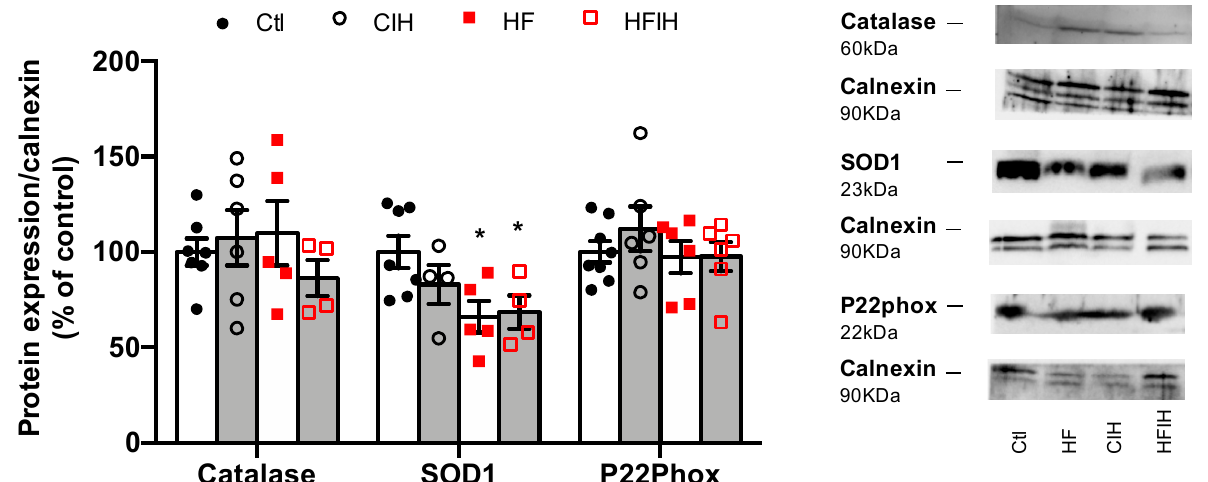
Figure 6. Effect of chronic intermittent hypoxia (CIH/IH) exposure on adipose tissue oxidative stress in control and high-fat (HF) animals. Effect of severe CIH on catalase (60 kDa), superoxide dismutase (SOD1, 23 kDa), and P22Phox (22 kDa) immunoreactivity in control and HF animals in relation to the expression of the loading protein, calnexin (90 kDa). Representative Western blots for each protein studied are depicted in the right panel. Data are presented as means ± SEM of 4–8 animals. One- and two-way ANOVA with Dunnett’s and Bonferroni multiple comparison tests, respectively: * p < 0.05, compared with control animals.